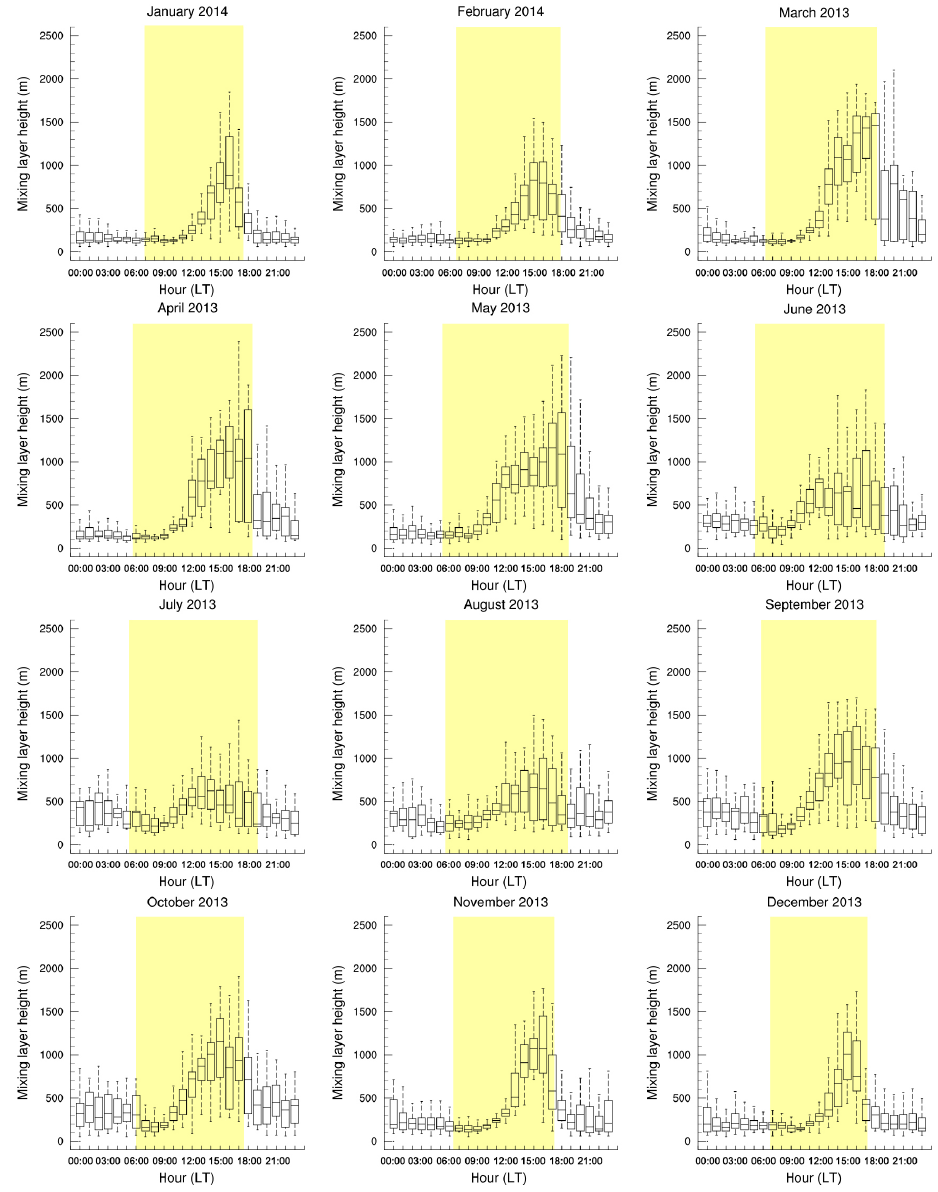
Figure 3. Monthly diurnal cycle of the MLH as box-and-whisker plots (showing the median, the upper and lower quantile and whisker) at the Bode site in the time period March 2013 to February 2014: (top left) January 2014) to (bottom right) December 2013. The yellow shading indicates the daylight periods on the 15th of each